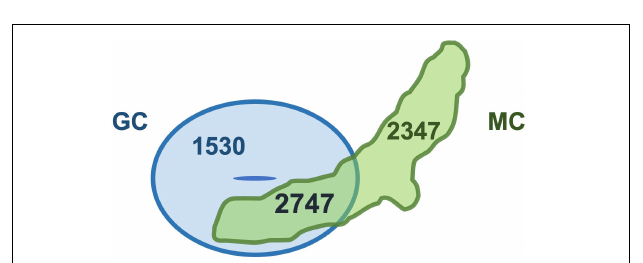
FIGURE 2 | Two specialized cells share thousands of genes. Venn diagram of genes specifically expressed in guard cells (GC) and myrosin cells (MC). Original data were reported in Berrío et al.